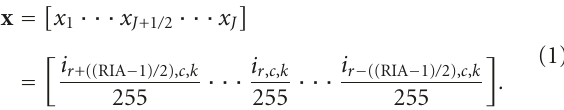
proposed system for an integration of 5 cells in 1D and 2D modes. So, di ff erent output radar images ( O ) are obtained, being analyzed in Section